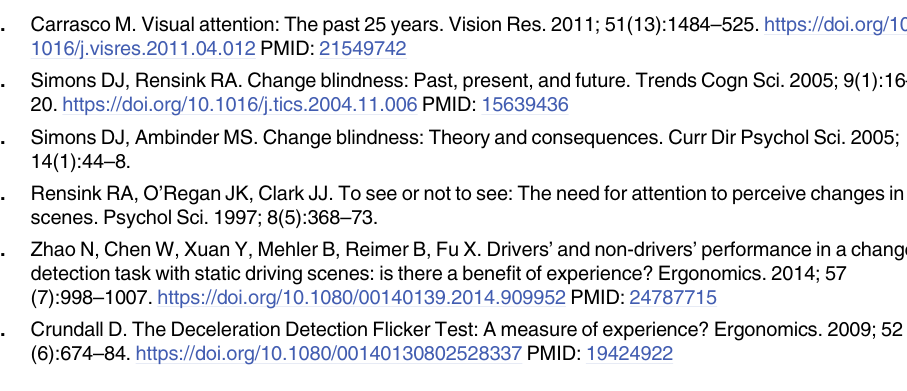
S8 Fig. Model saccade probability matrices, and correlations with human data (control analyses). A-B. Same as in Fig 7C and 7D (main text), except with replacing DeepGaze’s saliency algorithm with the frequency-tuned salient region detection algorithm. C-D. Same as in Fig 7C and 7D (main text) except including only saccades whose amplitude was at least as large (or greater) than the 10 th percentile of saccade amplitudes generated by the DeepGaze model (Fig 7B, main text, dashed vertical line). For C, the saccade probability matrix was nor- malized by its range for visualization purposes only. Other conventions are the same as in Fig 7C and 7D (main text). S1 Table. List of images employed in the change blindness